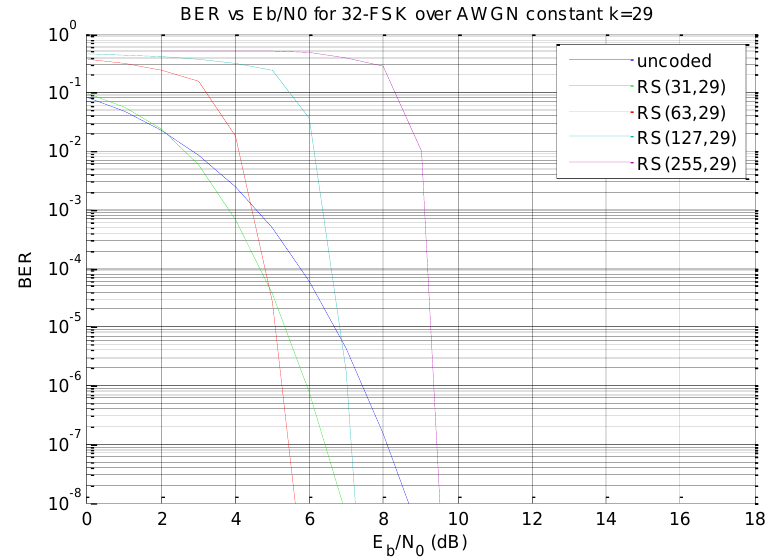
Figure 9. RS error performance for MFSK over AWGN channel with constant k, increasing n – k